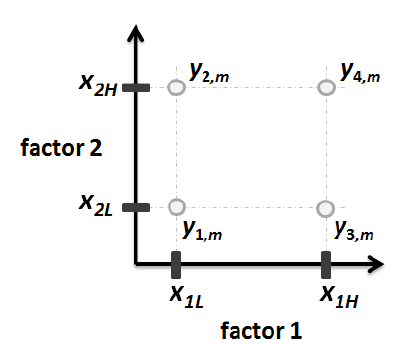
Figure 5: Points of experiments for a two-factor generalized experimental